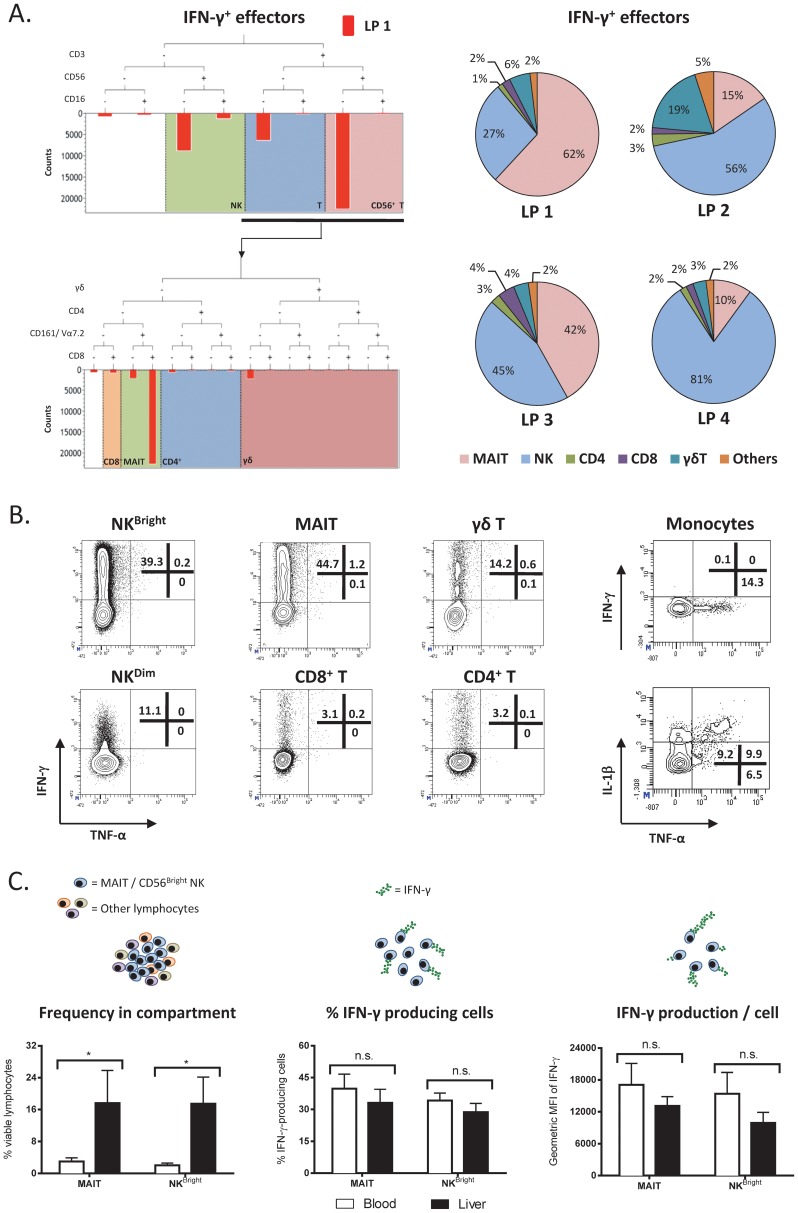
Characterization of intrahepatic immune cell subsets that produce IFN-γ upon TLR8 agonist stimulation.
(A) The left panel shows a tree plot depicting lymphocyte subsets within the healthy liver compartment that produce IFN-γ upon ssRNA40 stimulation. A representative donor, LP1, is presented. Pie charts illustrate the same data from 4 healthy donors, LP1-LP4. (B) Production of IFN-γ, TNF-α and IL-1β by seven immune cell subsets within the liver compartment upon ssRNA40 stimulation. The frequency of cytokine-producing cells within each subset is shown in the quadrants. Representative contour plots of one healthy donor are presented. (C) Analysis of IFN-γ production by MAIT and NKBright cells within the peripheral blood (n = 3) and liver (n = 4) compartments of healthy donors. The left panel illustrates the frequency of MAIT or NKBright cells represented as a proportion of total viable lymphocytes in each compartment. The middle panel shows the frequency of IFN-γ-producing MAIT or NKBright cells in each compartment. The right panel shows the production of IFN-γ per cell within the MAIT or NKBright populations in each compartment. Values are displayed as mean±SD. * and n.s. indicate P<0.05 and P>0.05, respectively.